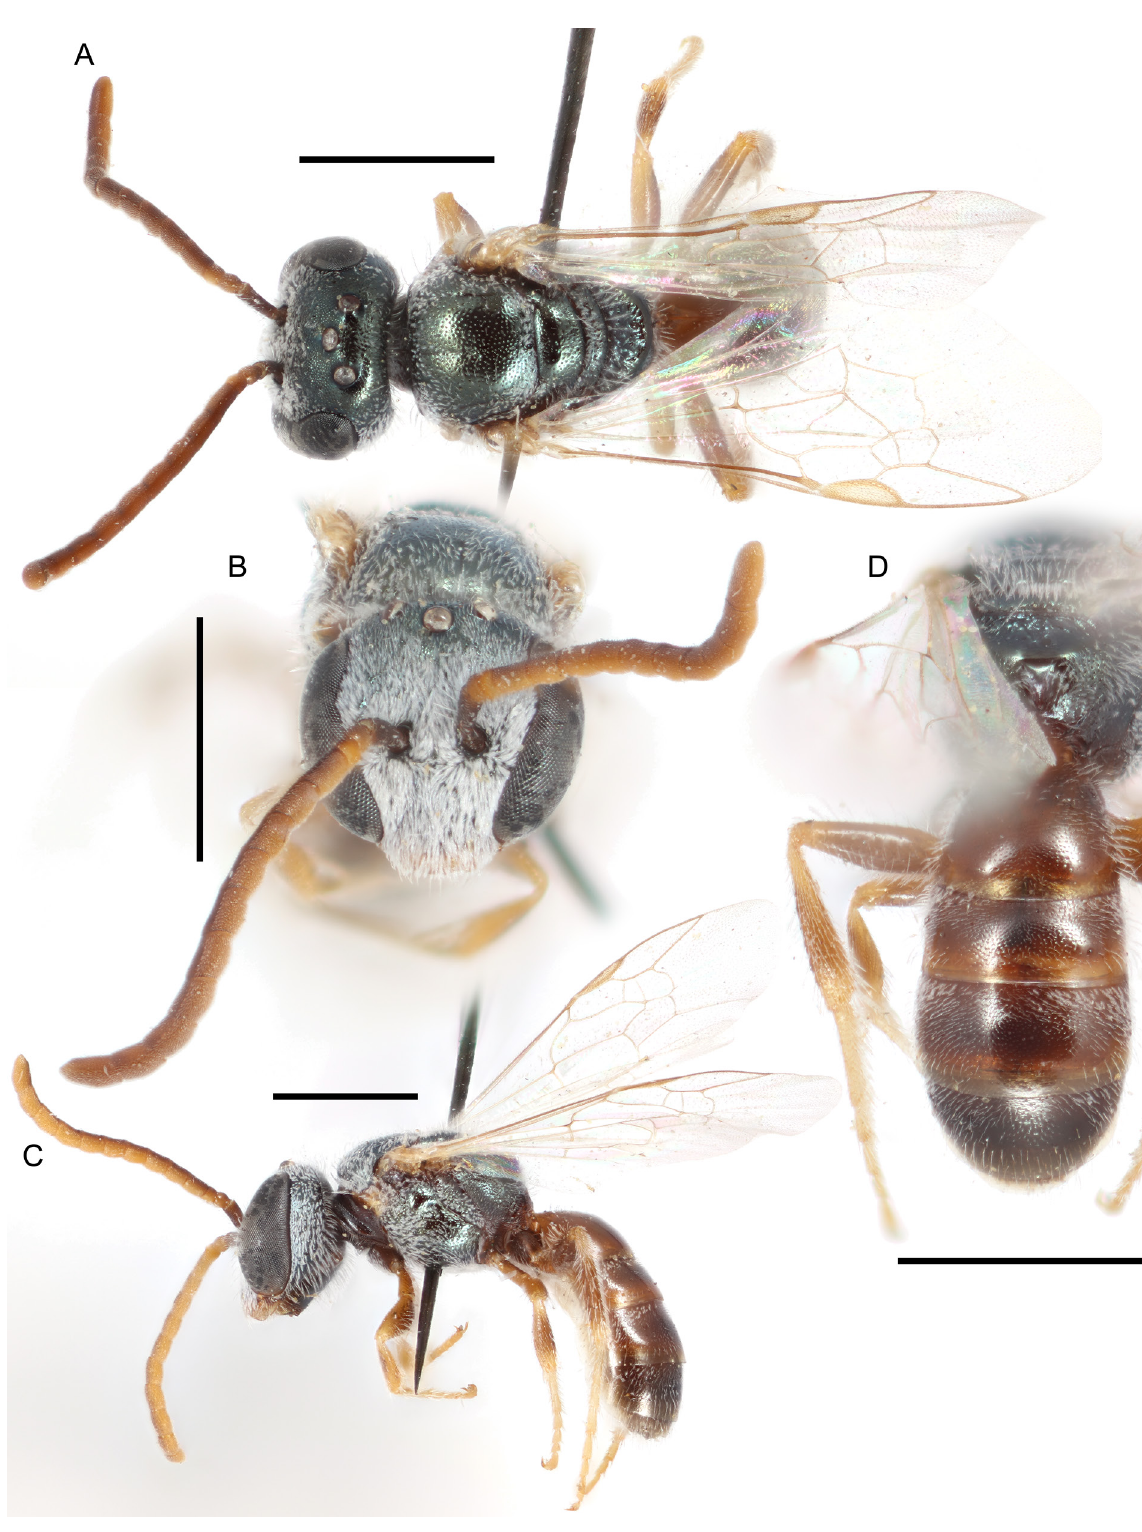
Fig. 56. Lasioglossum ( D. ) mesillense (Cockerell, 1898), ♂. A . Dorsal habitus. B . Face. C . Lateral habitus. D . Propodeum and metasoma. Scale bars: 1